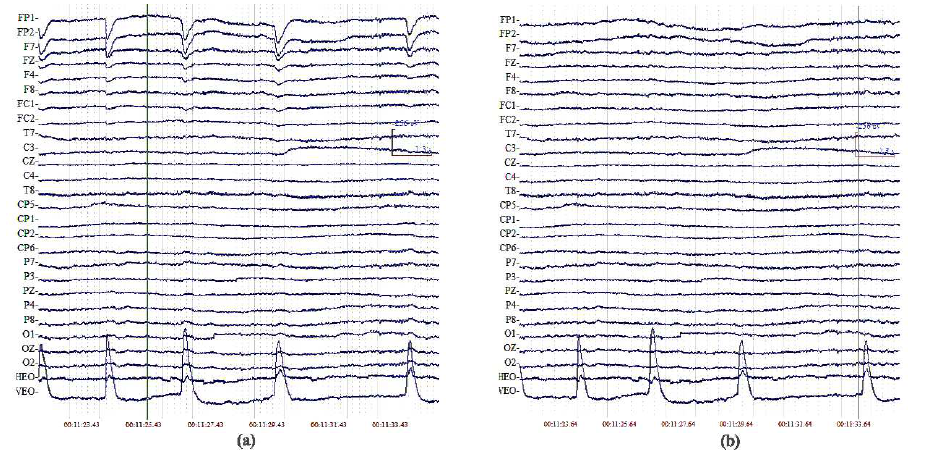
Figure 1. ( a ) original signals; ( b ) reconstructed signals after blink artifact removal by the ICA